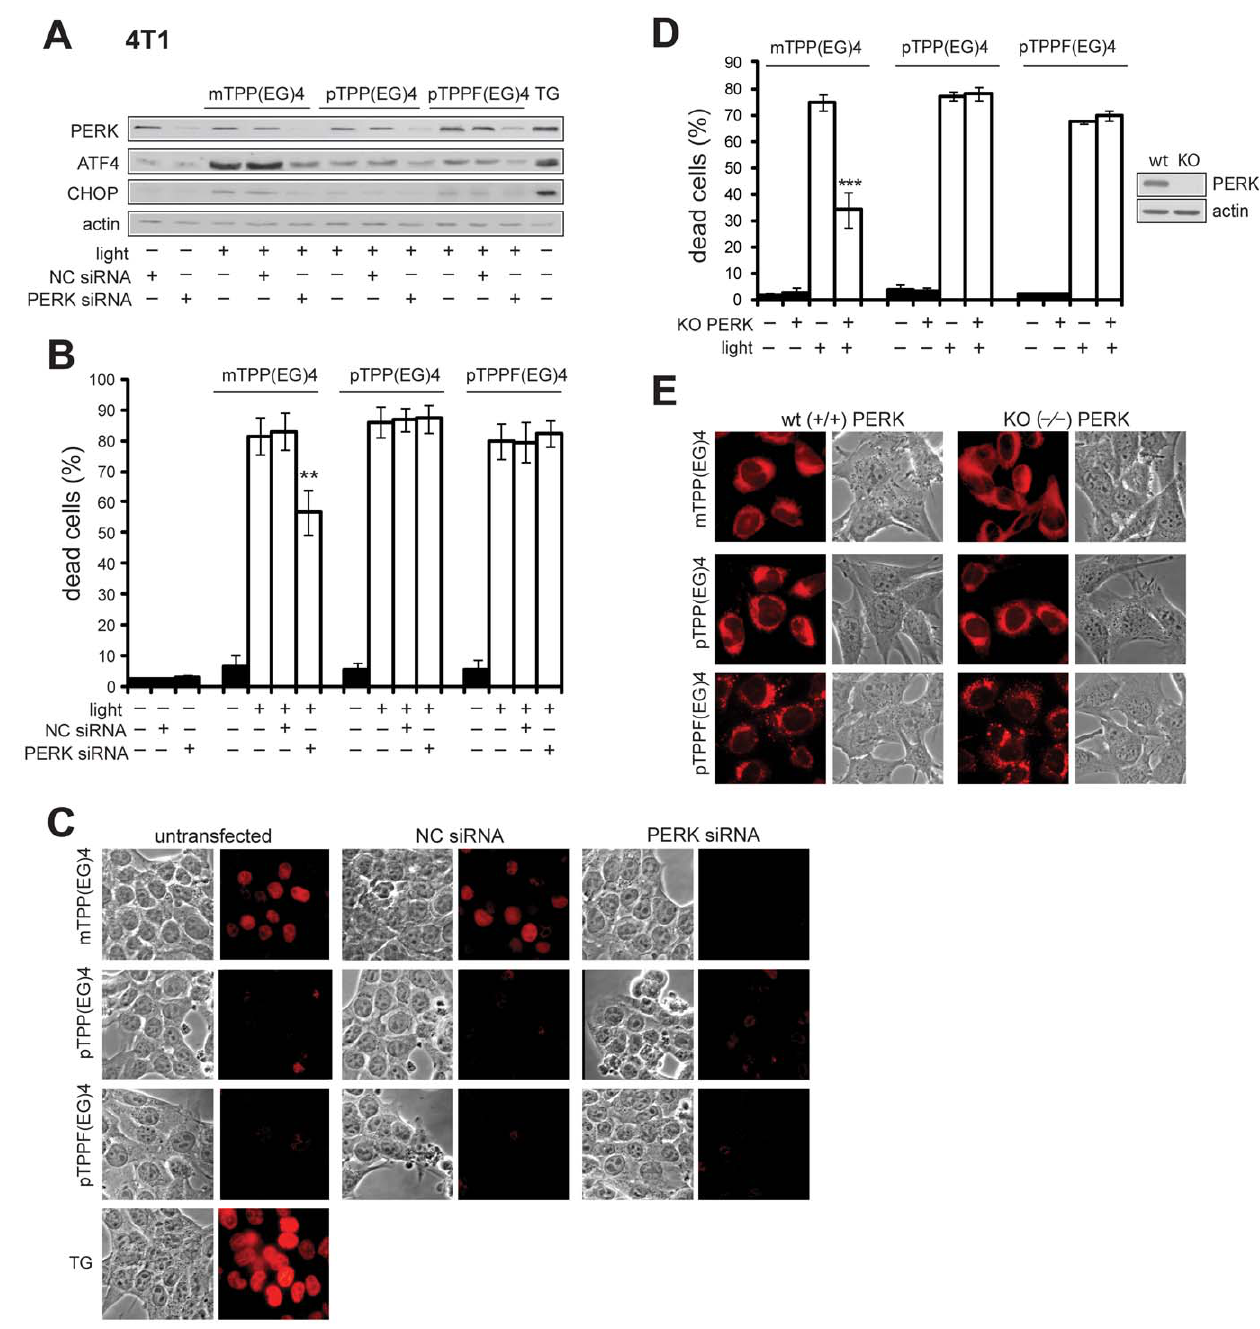
Figure 9. Effect of PERK siRNA on the demise of PDT-treated cells. PERK deficiency protects against mPTT(EG)4-mediated cell death. ( A ) Western blot analysis of PERK, ATF4 and CHOP in 4T1 cells after PERK siRNA transfection. Transfected cells were subjected to EG-porphyrin-mediated PDT, harvested and resolved by Western blot analysis. Equal protein loading is demonstrated by actin reprobing. As a positive control were used cells treated with 1 m M thapsigargin (TG) for 6 h. ( B ) Viability of cells transfected with PERK siRNA. Transfected and control cells were subjected to EG- porphyrin-mediated PDT and cell viability was monitored 24 h later. The percentage of dead cells was expressed as the mean 6 SD (n=7–14). **P , 0.01 represents the statistical difference between transfected PDT-treated cells vs. non-transfected or control siRNA-transfected PDT-treated cells. ( C ) Immunostaining of CHOP after EG-porphyrin derivative-mediated PDT in PERK knockdown cells. Cells were fixed 2 h post PDT, immunostained and observed with a fluorescence microscope. The left panel includes untransfected cells, the middle panel cells transfected with control siRNA and the right panel cells transfected with PERK siRNA. ( D ) Cell viability of MEF-wt and MEF-KO evaluated 24 h post-EG-porphyrin-PDT (350 nM mTPP(EG)4, 3.5 m M pTPP(EG)4, 700 nM pTPPF(EG)4). Verification of the PERK 2 / 2 phenotype in MEFs-KO cells by Western blot. The percentage of apoptotic cells was expressed as the mean 6 SD (n=6). ***P , 0.001 represents statistical differences between PDT-treated MEF-wt cells vs. PDT-treated MEF-KO cells. ( E ) Fluorescence microscopy demonstrates similar cellular uptake of EG-porphyrin derivatives in MEFs-wt and MEF- KO [800 nM mTPP(EG)4, 5 m M pTPP(EG)4, and 2 m M pTPPF(EG)4].